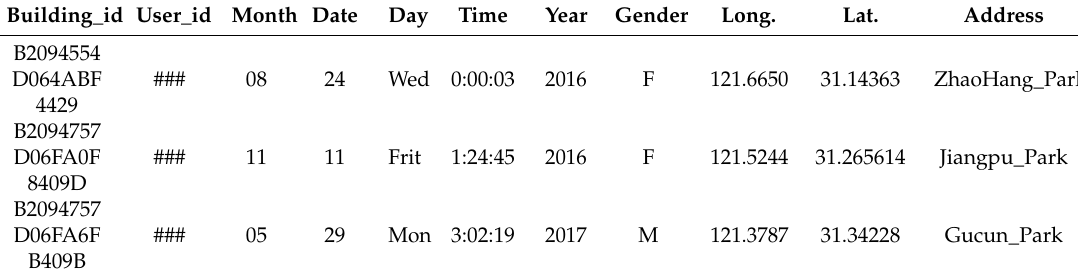
Table 3. Example of Weibo check-in.